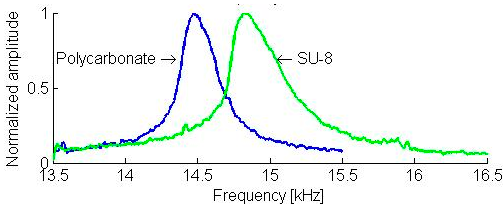
Figure 44. The contact resonance spectra of the first flexural mode of a 5-mm in length piezo-resistive cantilever microprobe in mechanical contact with a polycarbonate (blue curve) and an SU-8 sample.